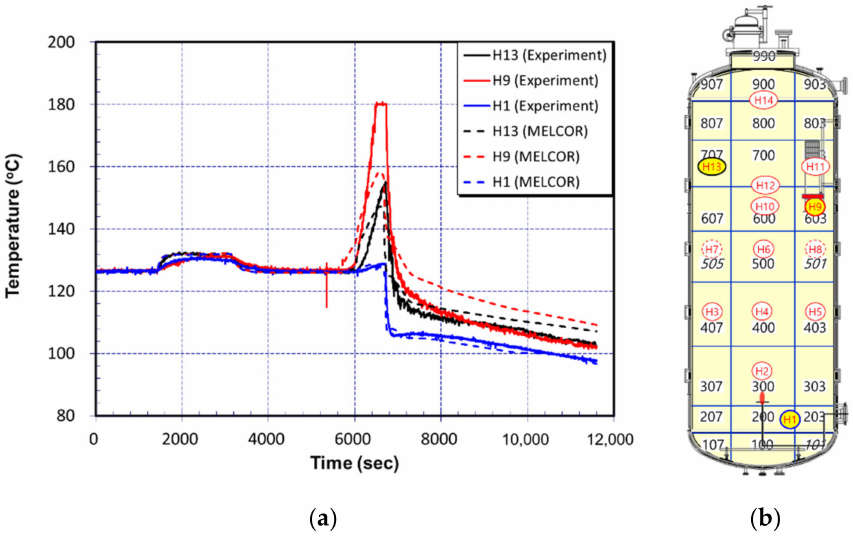
Figure 12. Comparison of MELCOR predictions with measurement data for SSP1 test: ( a ) Gas temperature; ( b ) Measurement